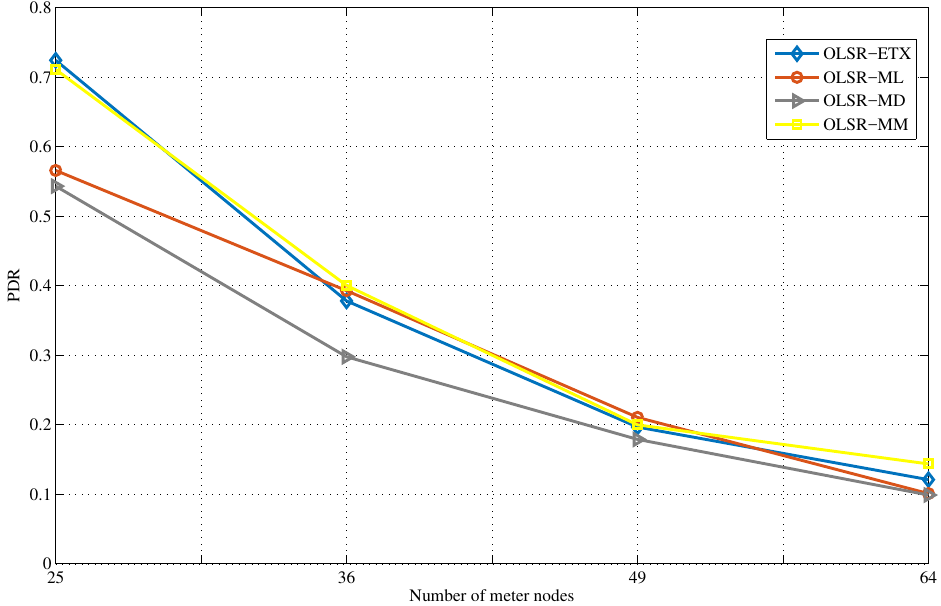
Figure 12. PDR for smart grid application on grid clusters with a central placement of the data concentrator.